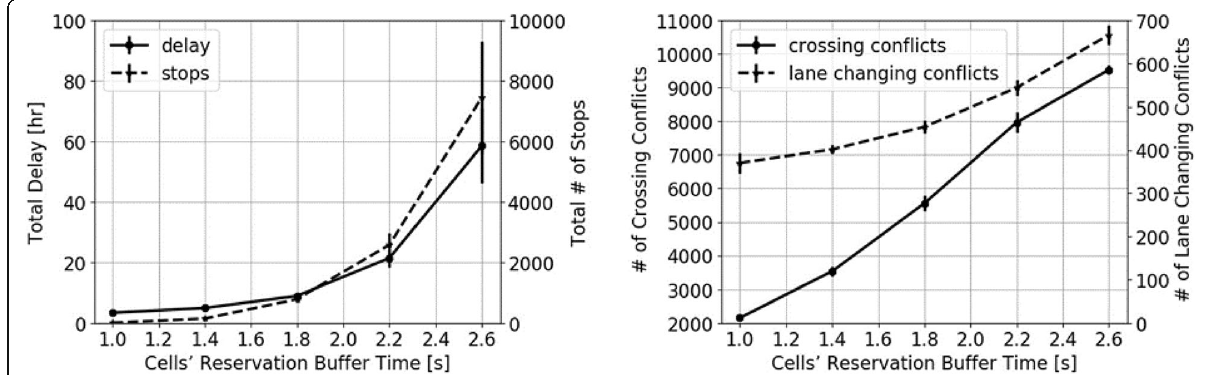
Fig. 5 Impact of reservation buffer time on delays, stops and